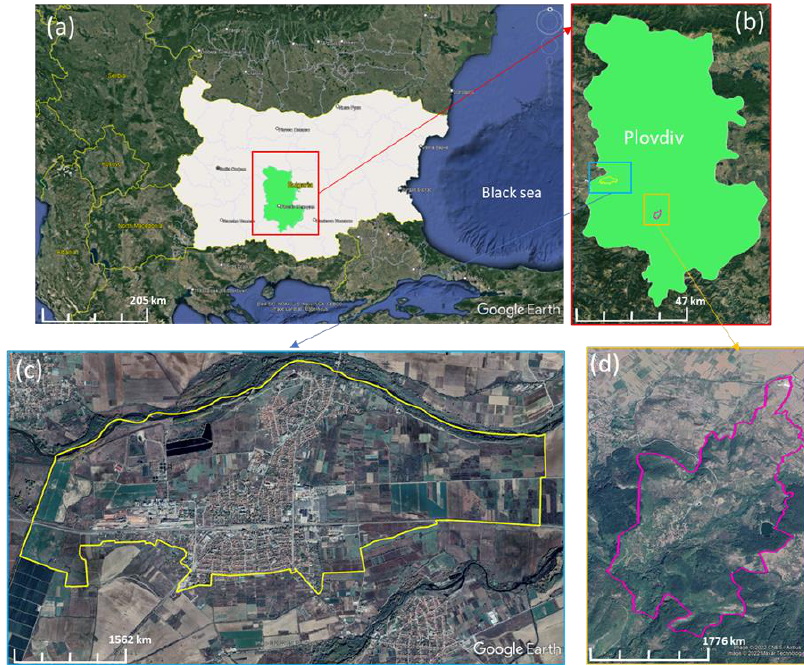
Figure 1. Location of Plovdiv district in Bulgaria and two populated regions as study sites in Plovdiv district ( a ) Bulgaria, ( b ) Plovdiv district, ( c ) Stamboliyski, and ( d ) Ruen. district ( a ) Bulgaria, ( b ) Plovdiv district, ( c ) Stamboliyski, and ( d )